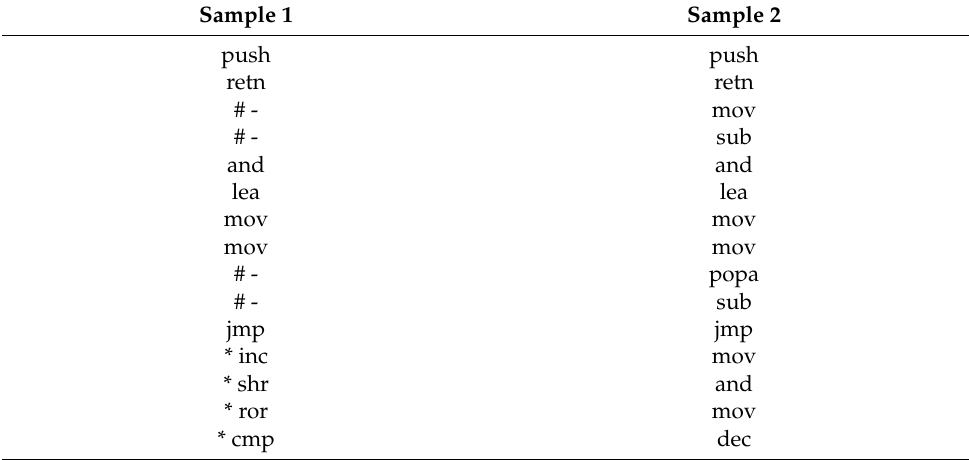
Table 8. Pairwise alignment of two samples generated using the NGVCK constructor. The sequence shows match, mismatch, and gaps inserted for aligning the